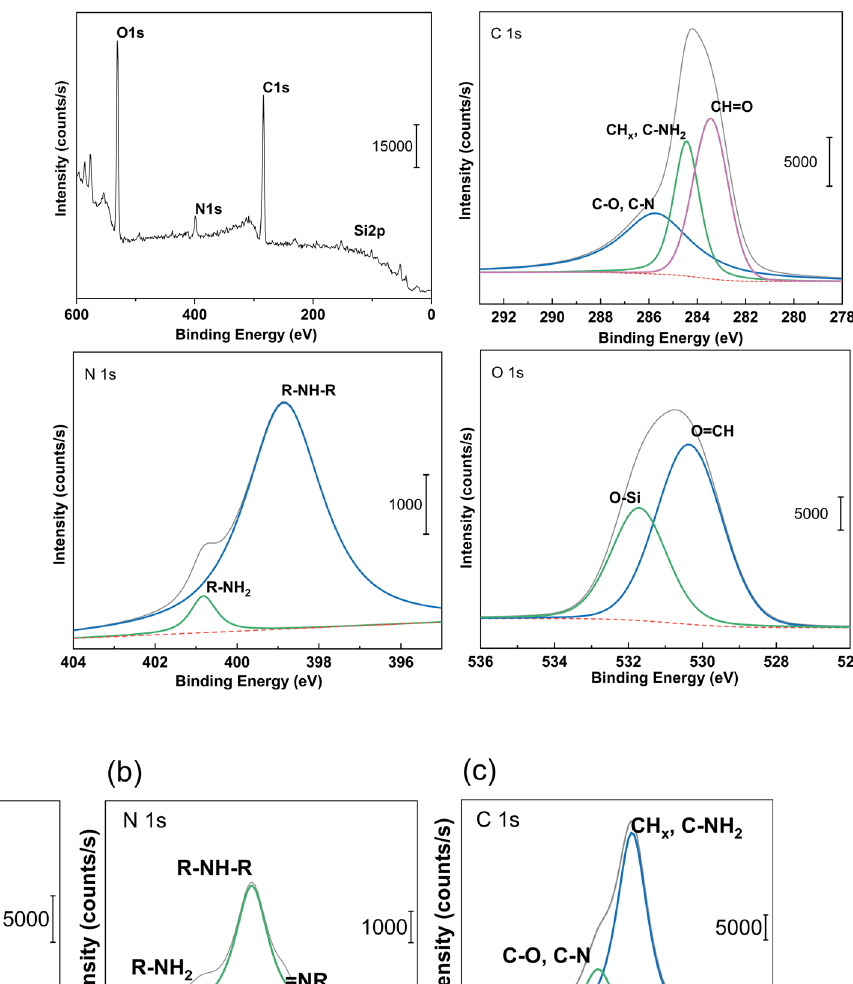
Fig. 2 Surveys of linked silane XPS outmost layer and O1s, C1s, and N1s binding energy levels